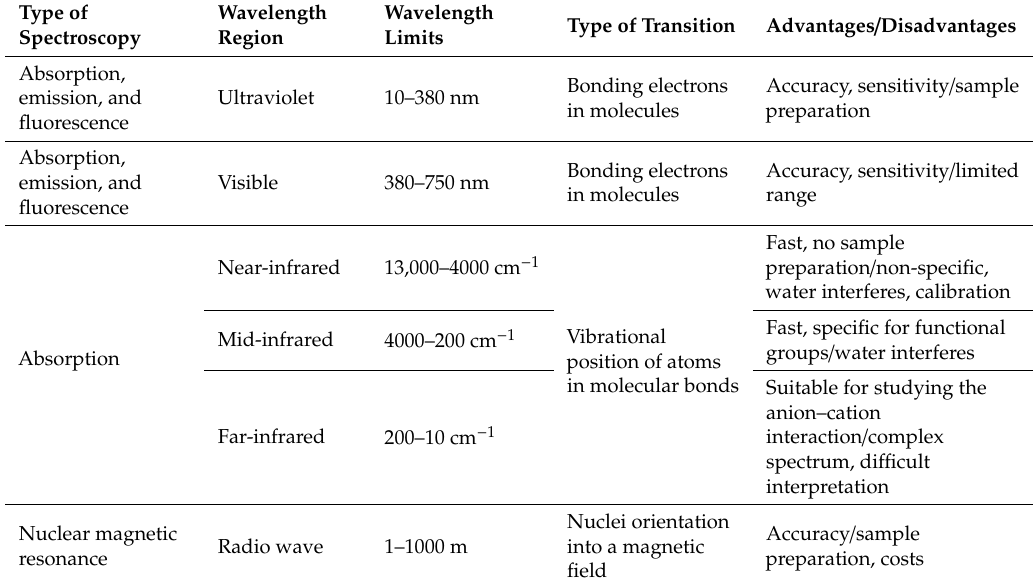
Table 1. Main spectroscopic techniques and their main